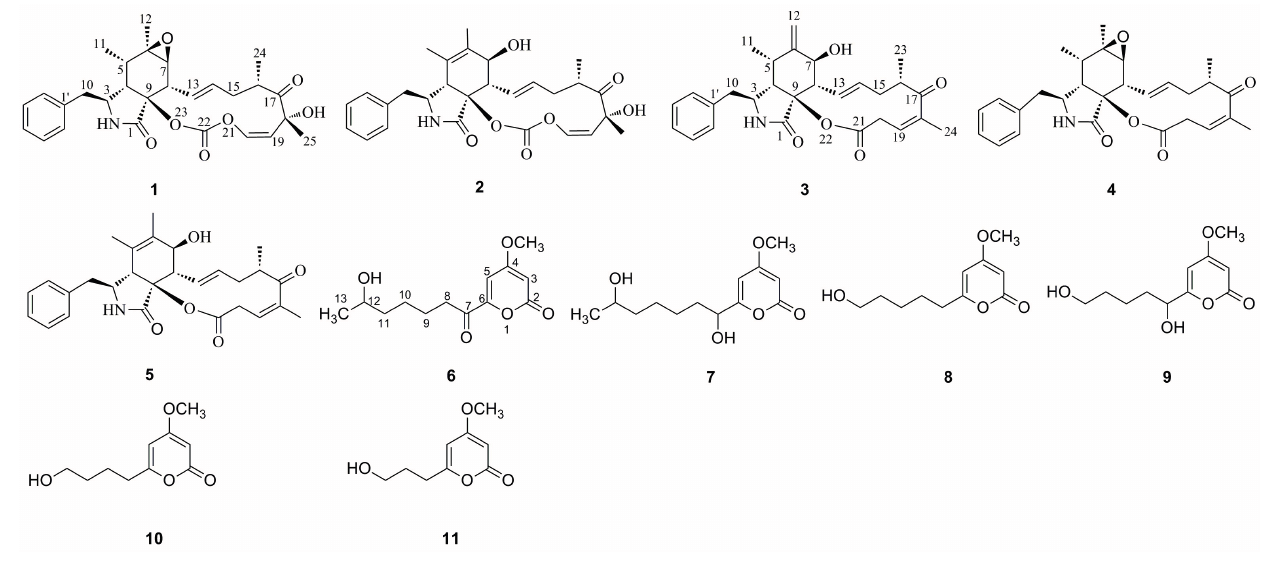
Figure 1. Structures of compounds 1 – 11